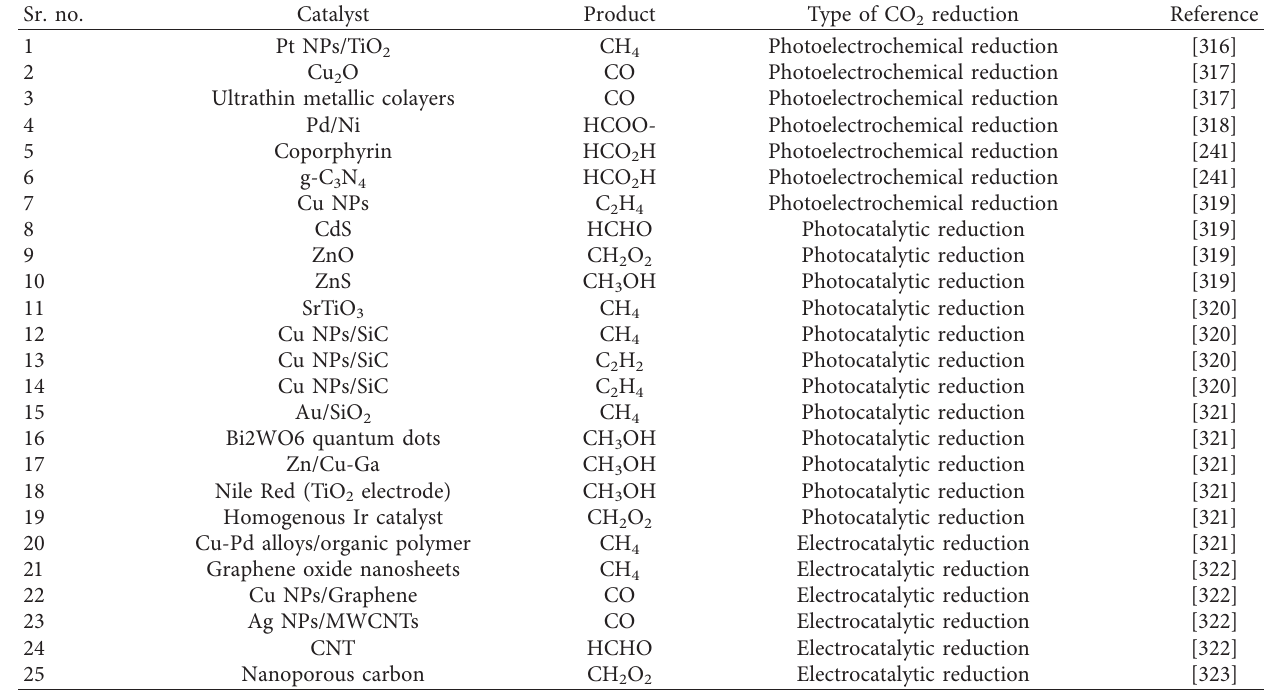
Table 13: Catalysts employed in copious types of carbon dioxide